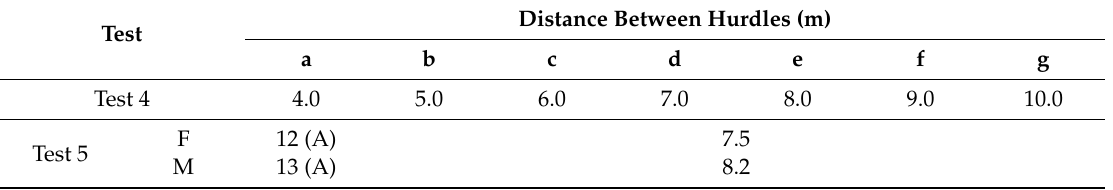
Table 1. The arrangement of hurdles in the test performed at jogging and running